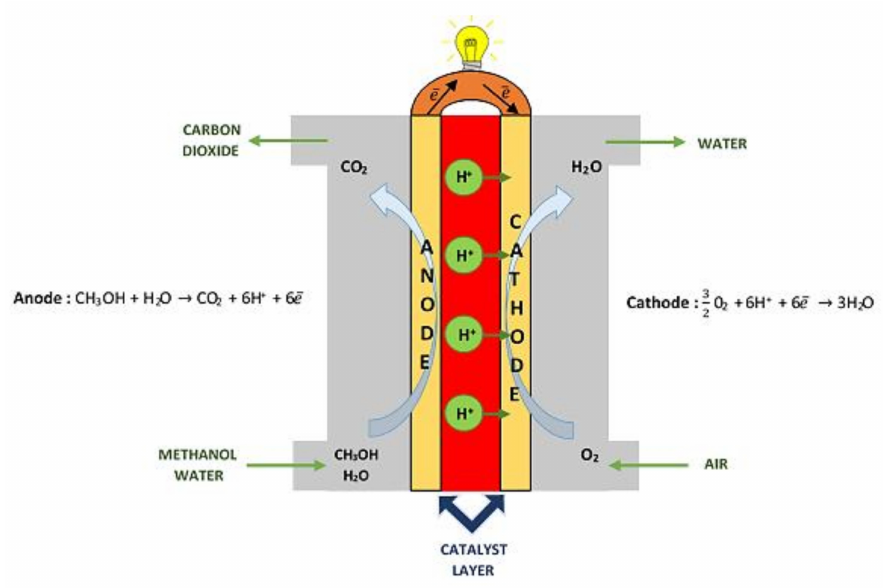
Figure 2. Direct methanol fuel cells